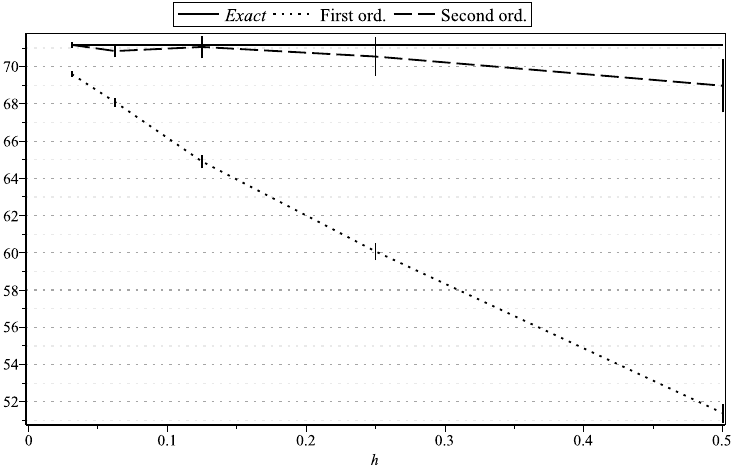
) 3 as functions of h : σ = 1.5, x 1